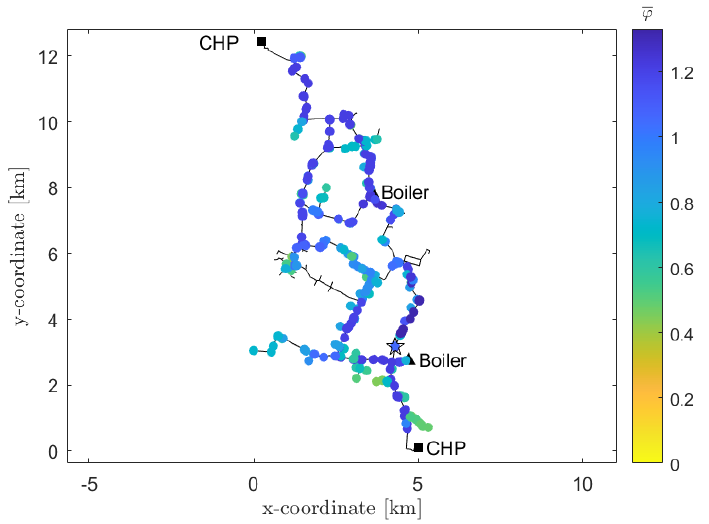
Figure 10. ϕ coefficient throughout the analyzed DH network with different configurations, using the mass-flow rate control strategy (the star indicates the best position for each configuration) − Configurations 1 to 6, mass-flow rate control strategy.